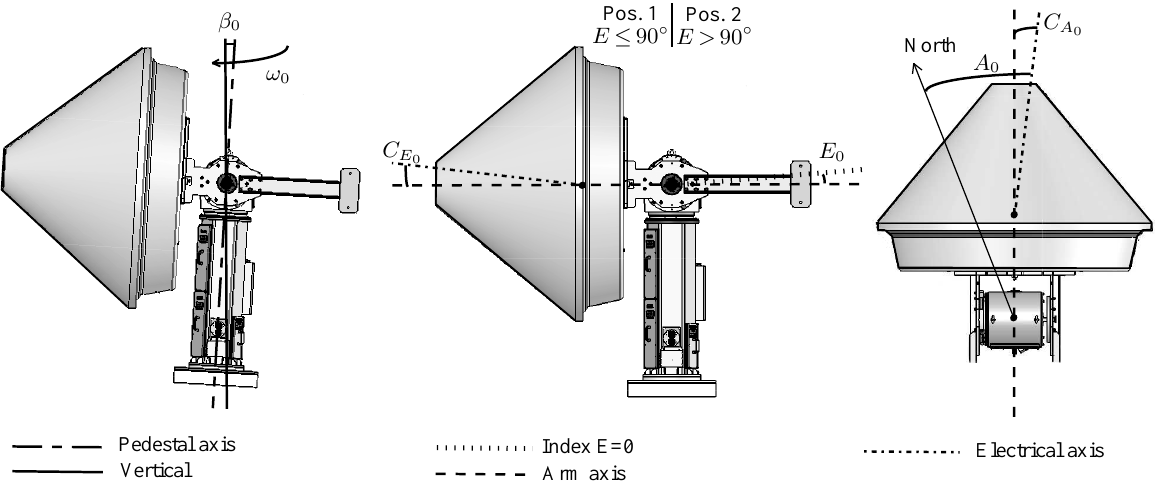
and C E ) and the index default affecting 0 0 ) and C E 0 0